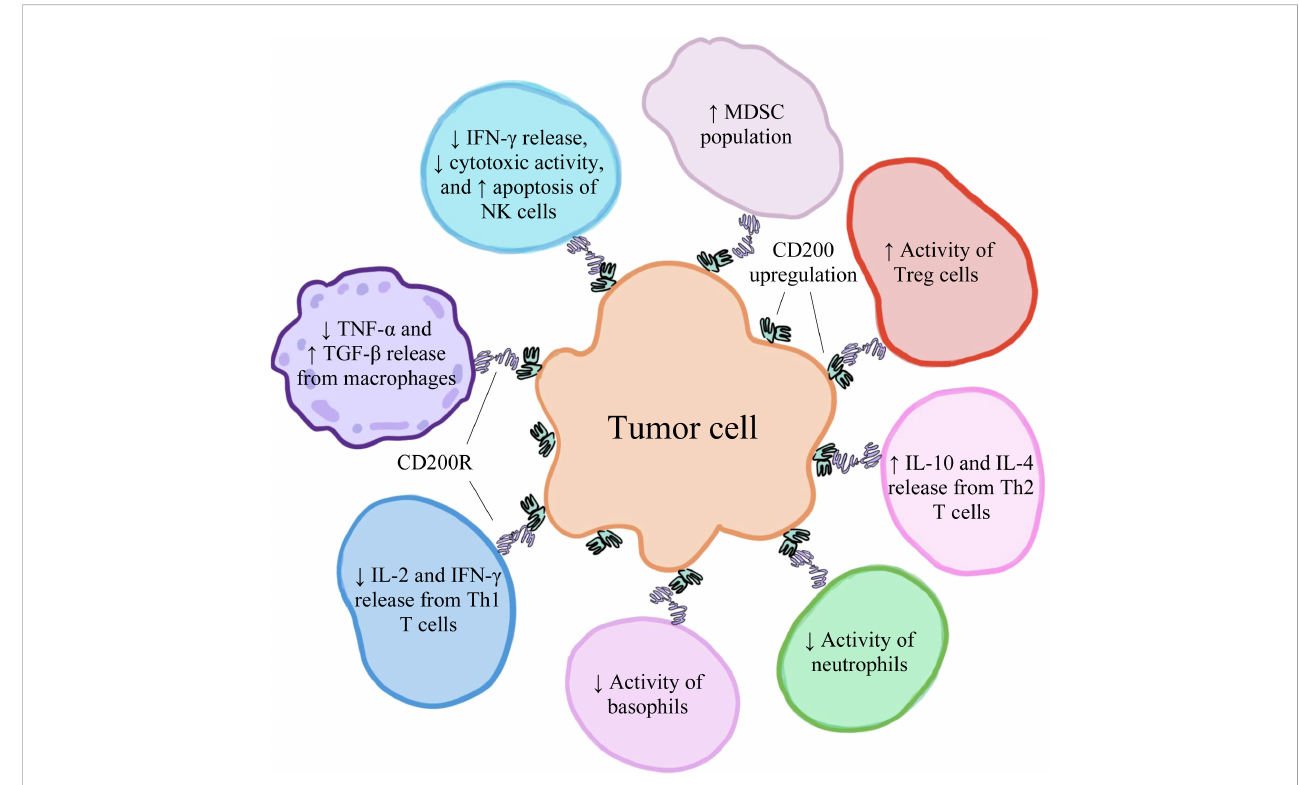
FIGURE 2 The upregulation of CD200 on various human cancer cells has an immunosuppressive effect on immune cells within the tumor microenvironment, creating conditions that favor tumor development, growth, and